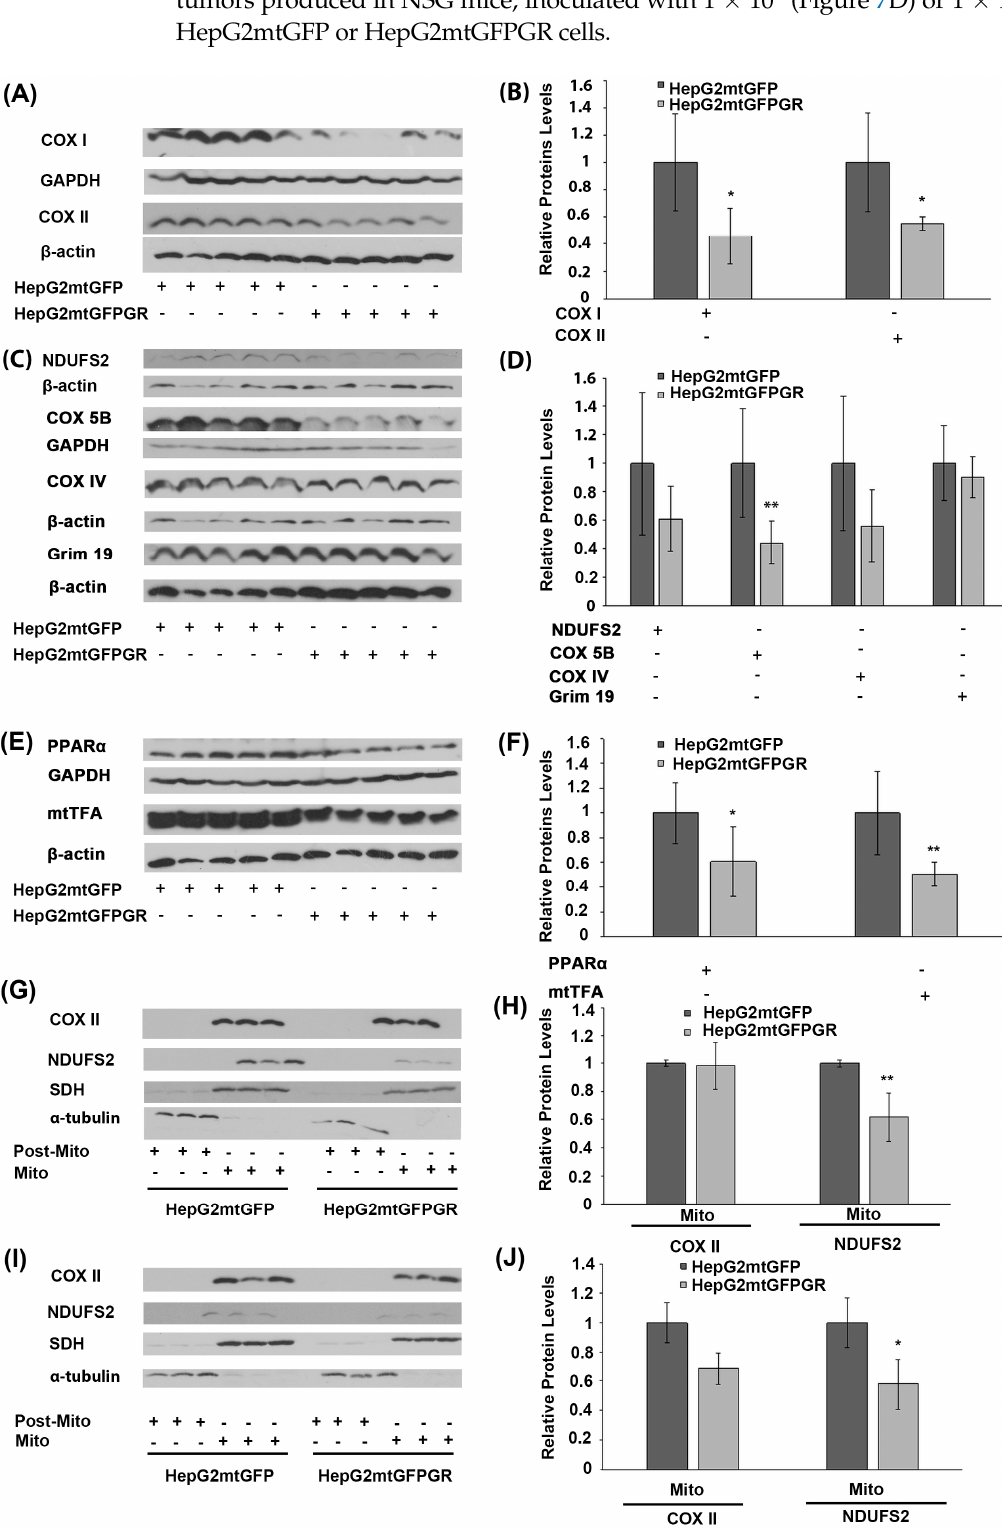
Figure 6. Regulation of OXPHOS biosynthesis by mtGR during tumor progression in human-to-mouse xenografts. Western blot analysis of ( A ) the mitochondrial-encoded OXPHOS subunits of COX I